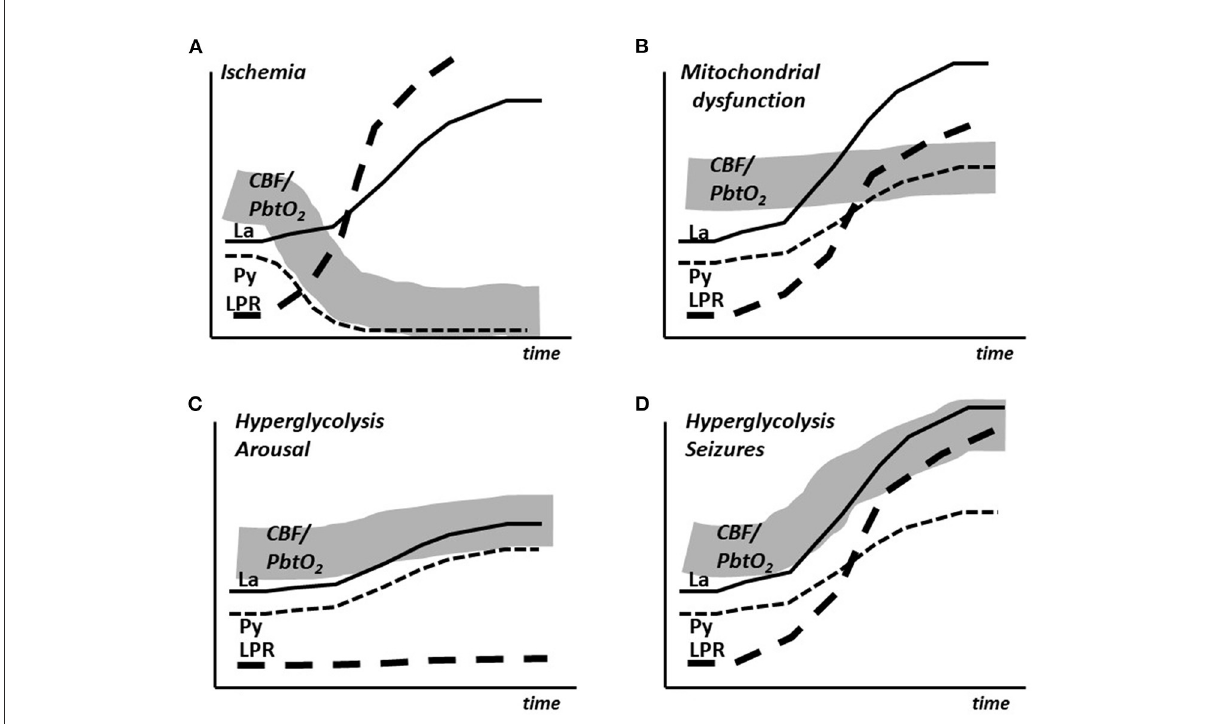
FIGURE3 Schematic illustration of the simultaneous changes in cerebral blood flow (CBF), brain tissue oxygen tension (PbtO 2 ) and the intracerebral levels of lactate (La), pyruvate (Py) and lactate/pyruvate ratio (LPR) in cerebral ischemia (A) , mitochondrial dysfunction (B) , arousal (C) and epileptic seizures (D)